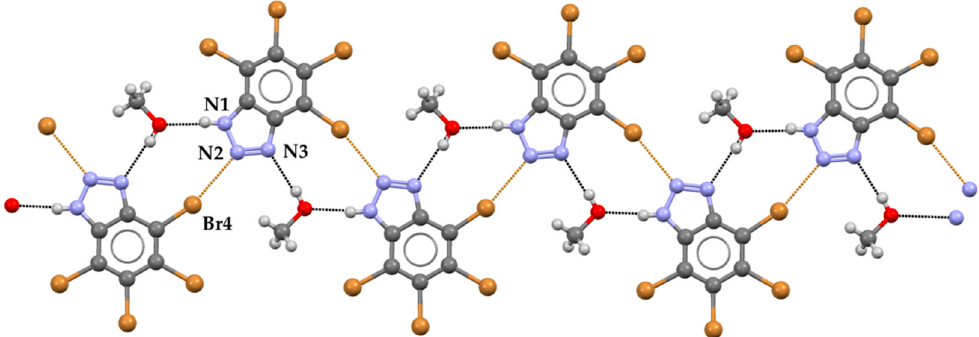
Figure 1. Partial view (Mercury 3.9, ball and stick representation) of one ribbon in the crystal structure of 1 . XBs and HBs are brown and black dotted lines, respectively. Color code: carbon, grey; hydrogen, light grey; nitrogen, light blue; bromine, brown; oxygen, red.